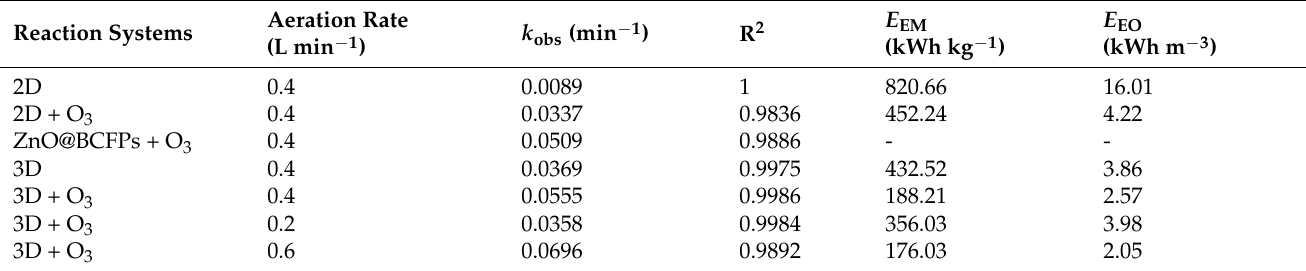
Table 2. Fitting parameters of pseudo-first-order kinetic model and energy consumption in differ- ent